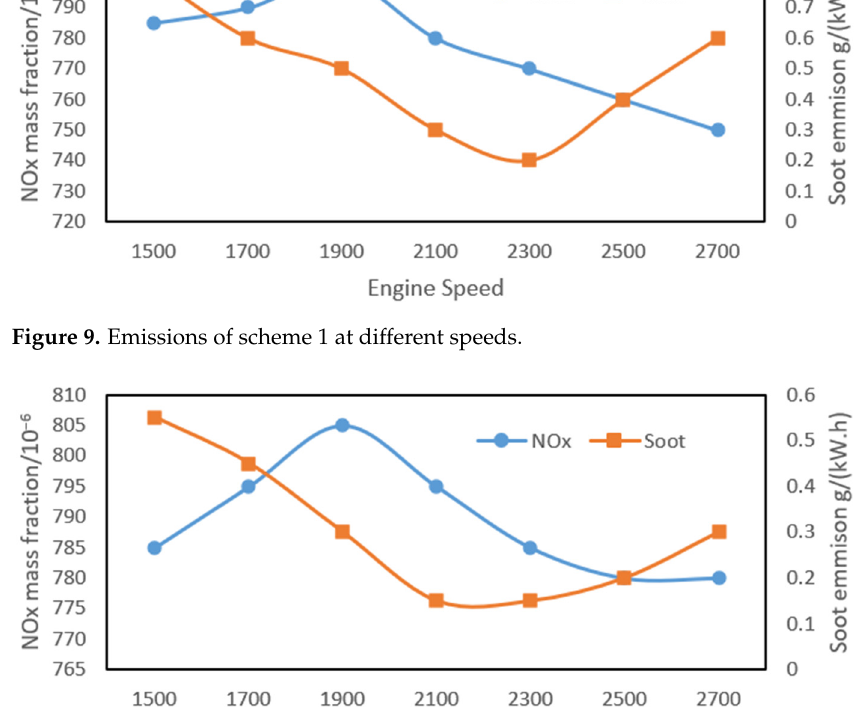
Figure 9. Emissions of scheme 1 at different speeds.